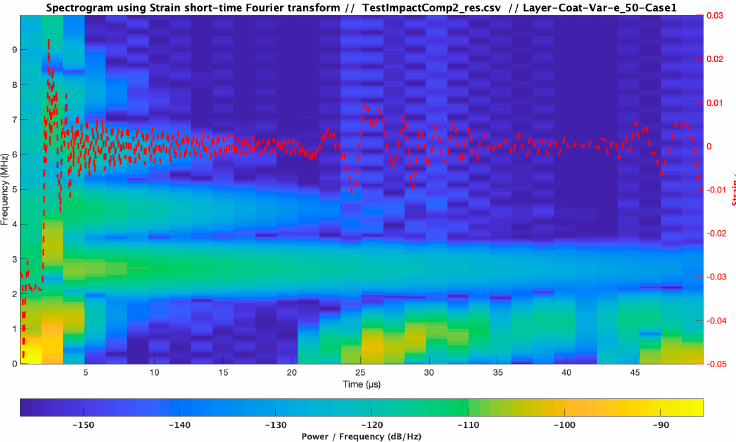
Figure 25. Spectrogram for strain evolution at the middle coating layer, 50% thickness, considering substrate-filler as semi-infinite with defined coating thickness for reference LEP configuration. Case 1.